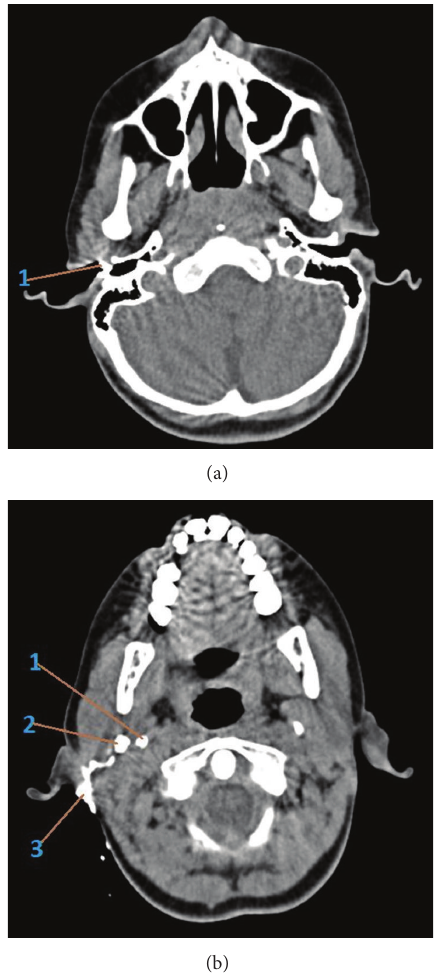
Figure 4: (a) CT fistulogram axial section showing the opening into the external auditory canal at bony cartilaginous junction (marked as 1). (b) CT fistulogram axial section (lower section to Figure 4(a)) showing the bifurcation of the fistula tract. (1) Styloid process, (2) main fistula tract going towards external auditory canal, and (3) bifurcation going to the postaural region with spillage of contrast.